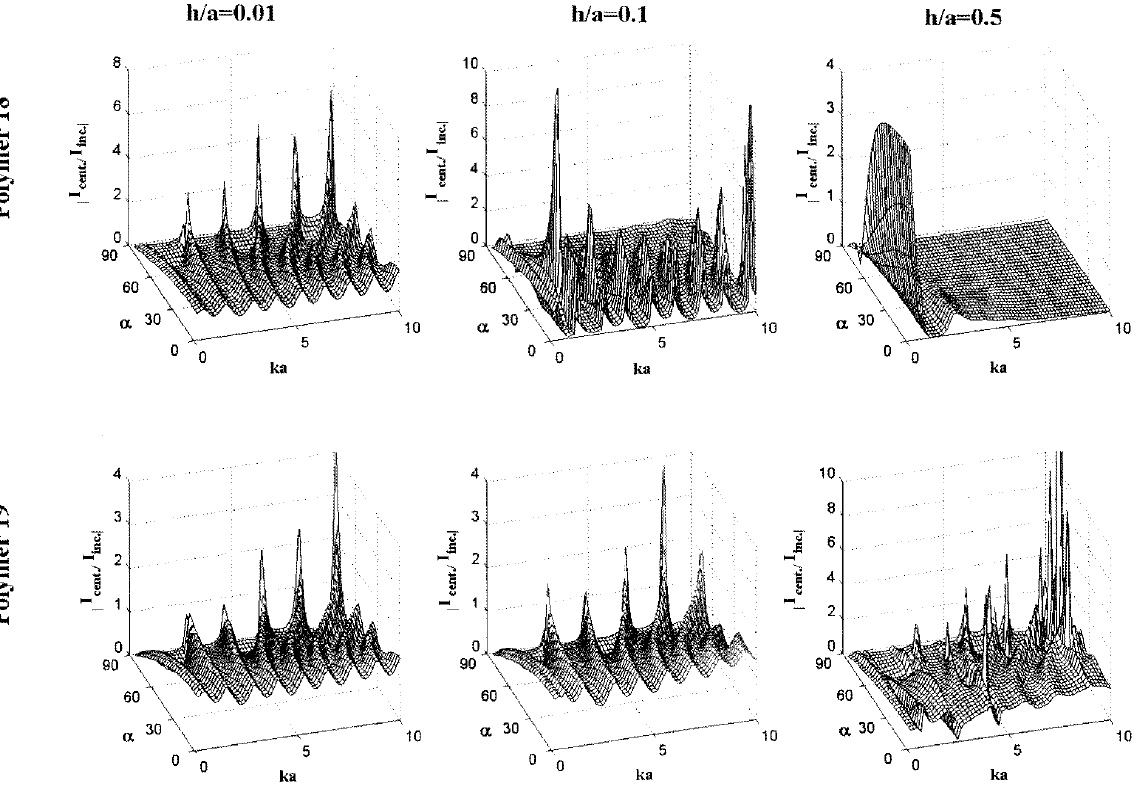
Fig. 12. Normalized force magnitude on the fluid-filled viscoelastic cylindrical shell versus nondimensional frequency and angle of wave incidence for selected shell